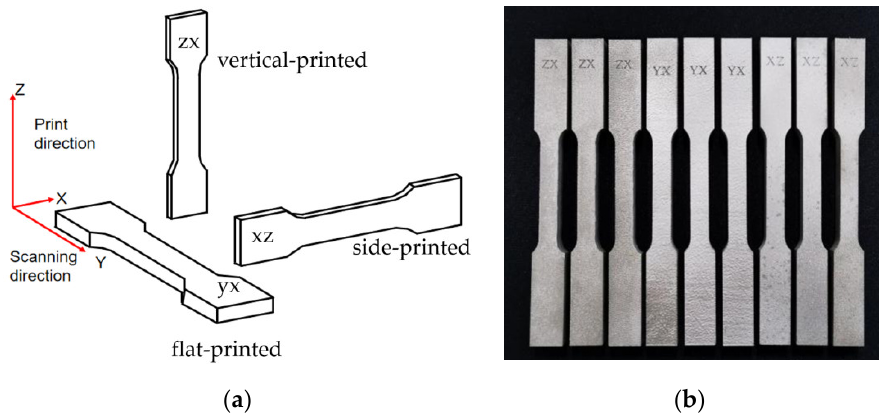
8 of 19 Table 1. Parameters of 316L stainless-steel sample. Name